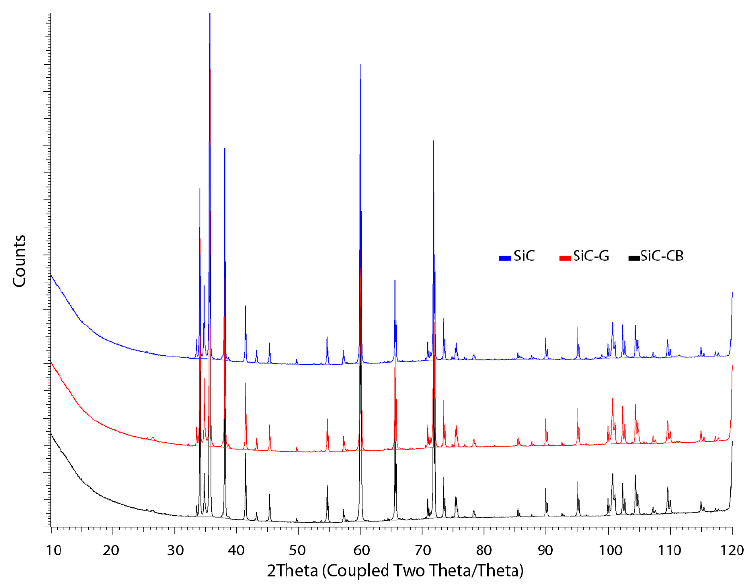
Figure 10. XRD patterns comparison of the 3 different 50/50 sinter types.